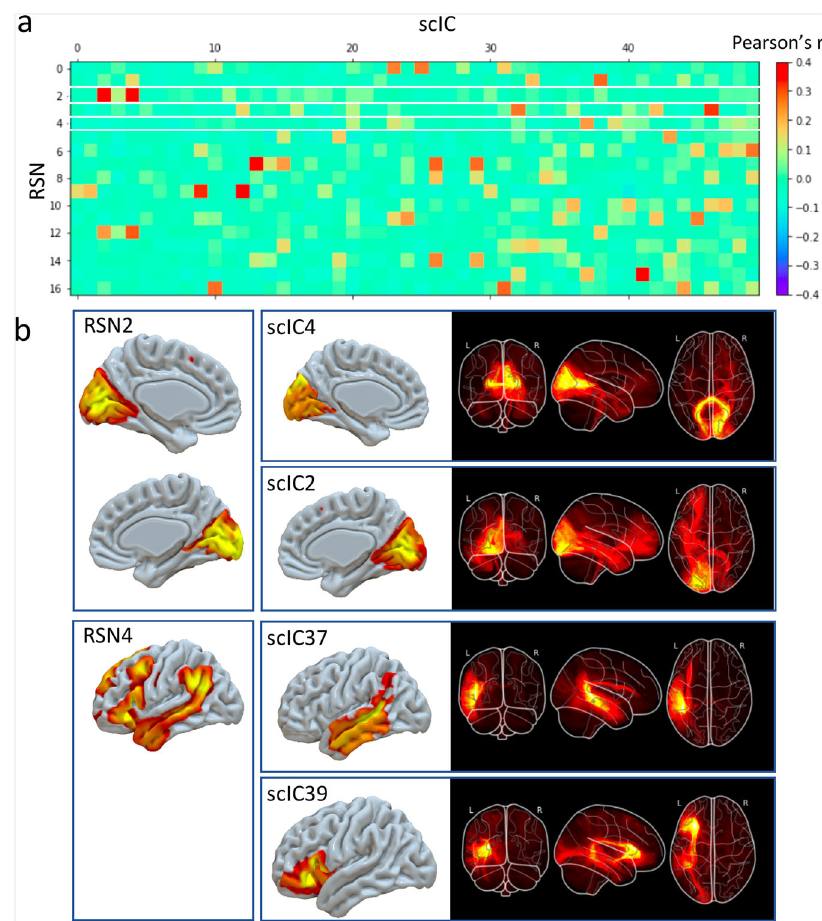
Fig. 1 Comparison of resting-state networks with structural connectivity independent components. Top panel ( a ) correlation matrix between the spatial maps of the 17 RSN with the grey matter maps of the 50 scICs. RSN2 and RSN4 are highlighted in white and further described in the bottom panel ( b ) alongside their corresponding scICs. RSN: resting-state networks, scIC: structural connectivity independent